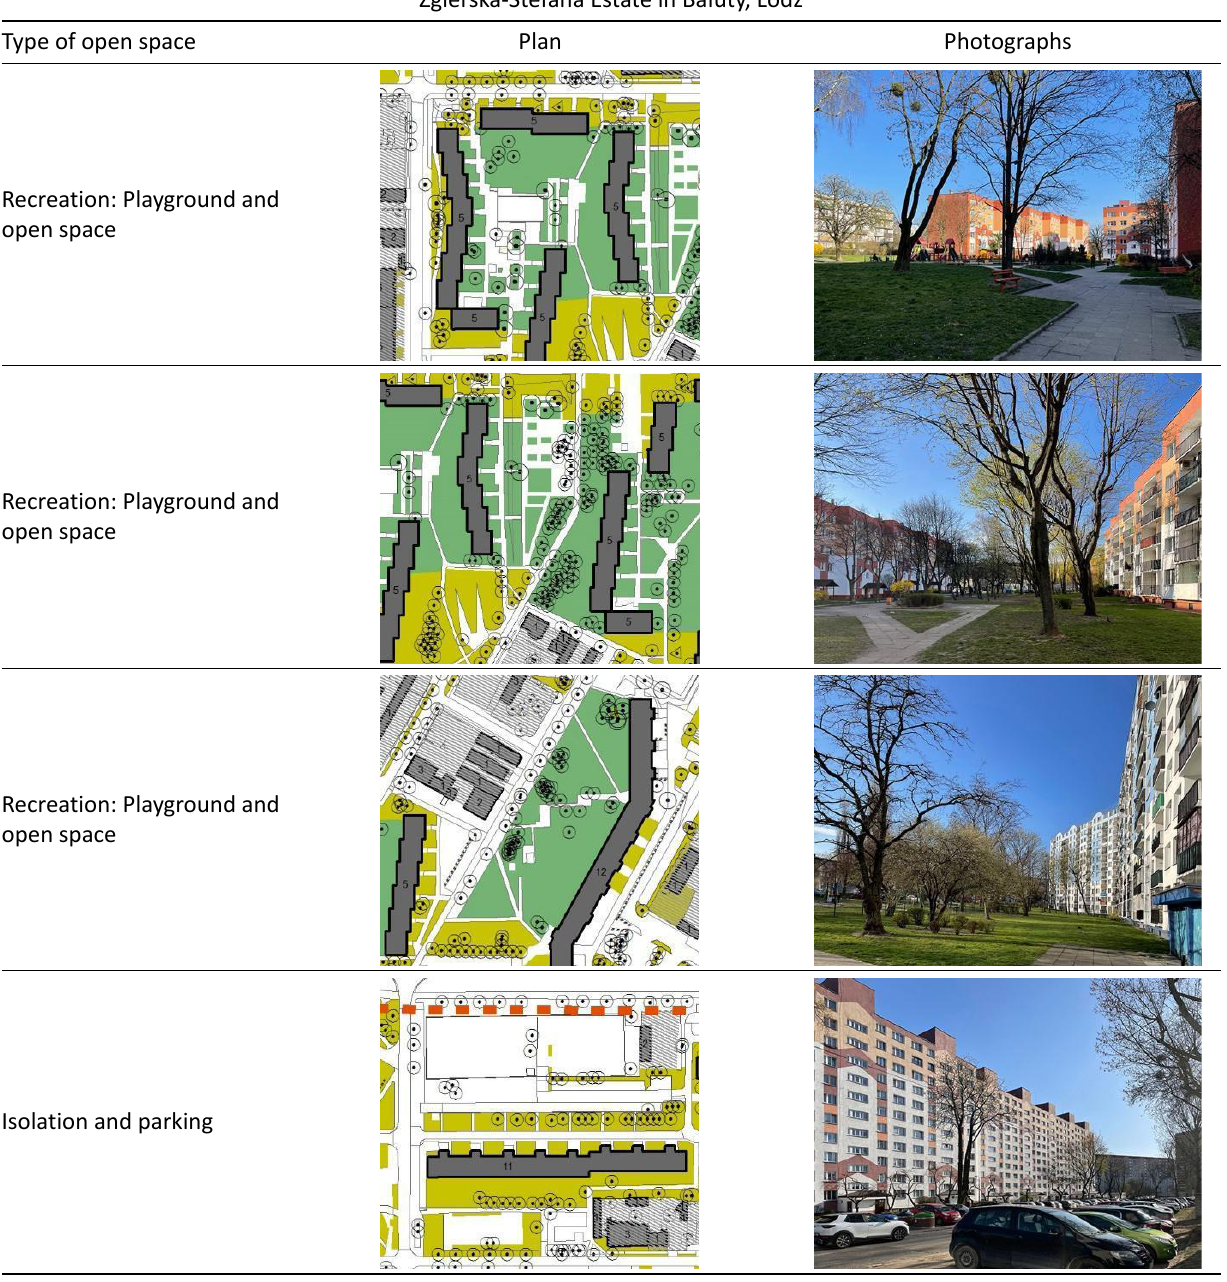
Table 3. Forms of open